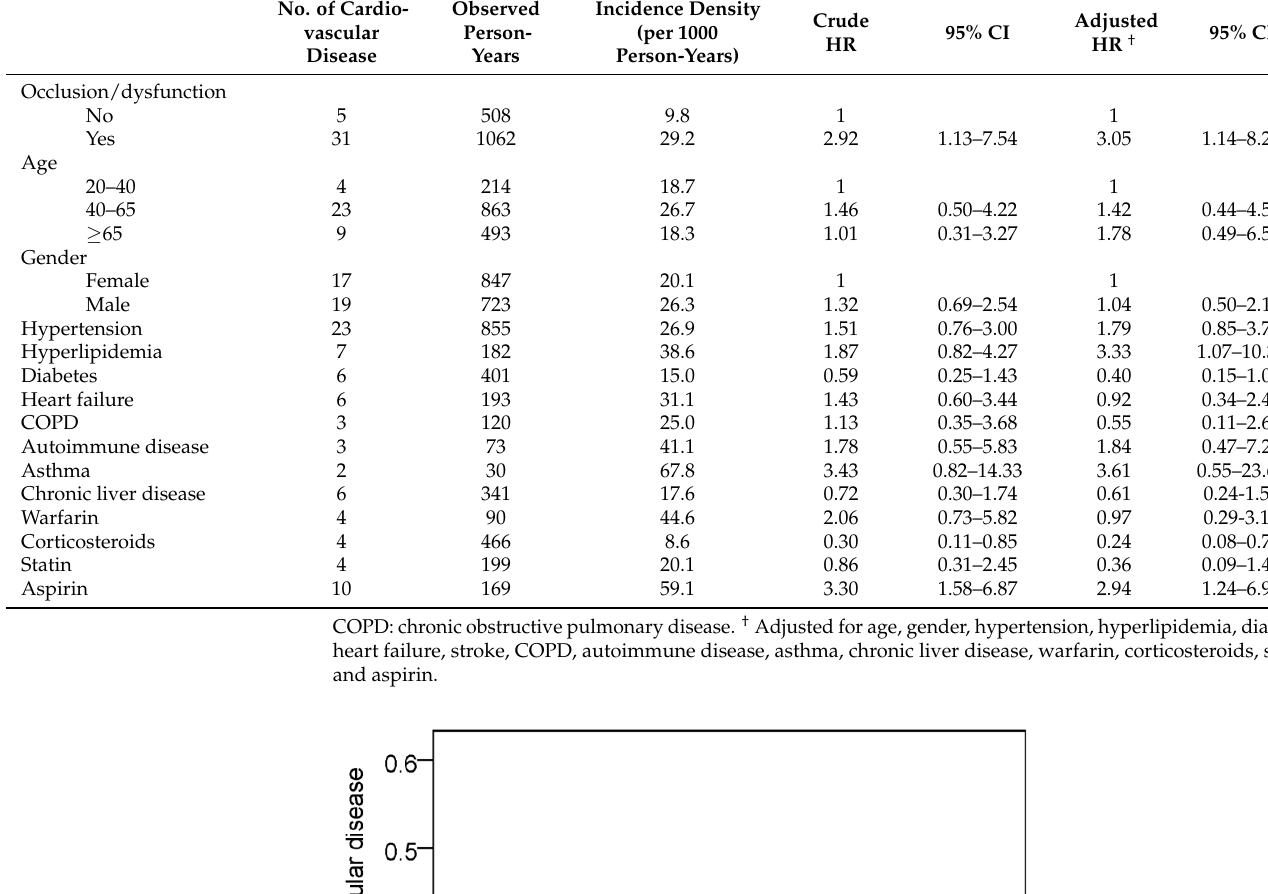
Table 2. Cox proportional hazard model.